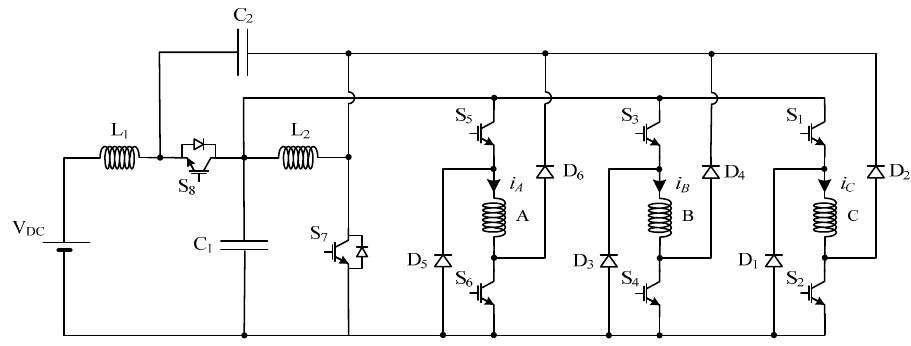
Figure 20. Converter with a modified quasi-Z network.